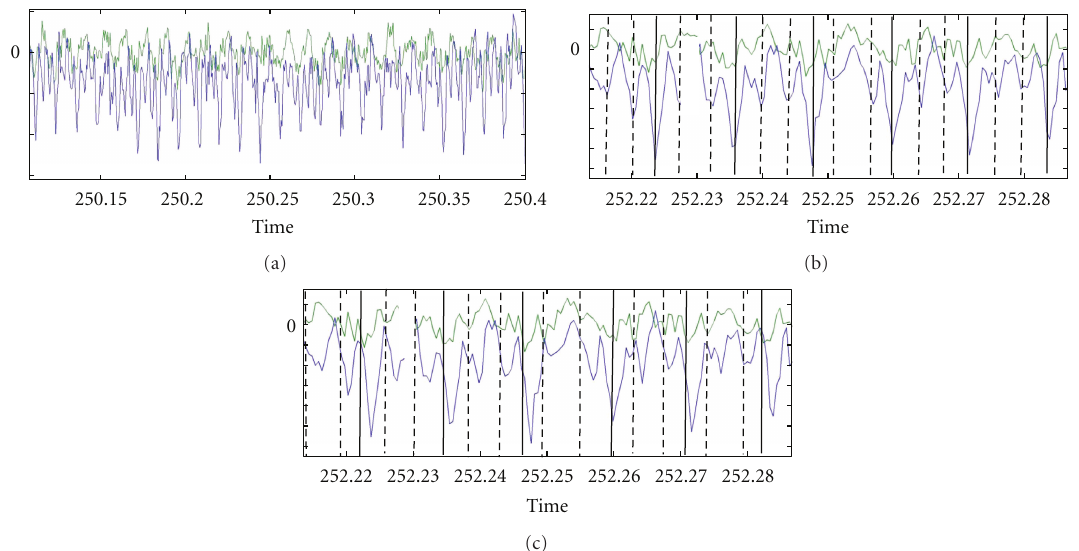
Figure 15: Zoom on the signals of F y (in blue) and F z (in green), 1.18 Q n , N ref , and low pass filter with cut-o ff frequency 400 Hz.